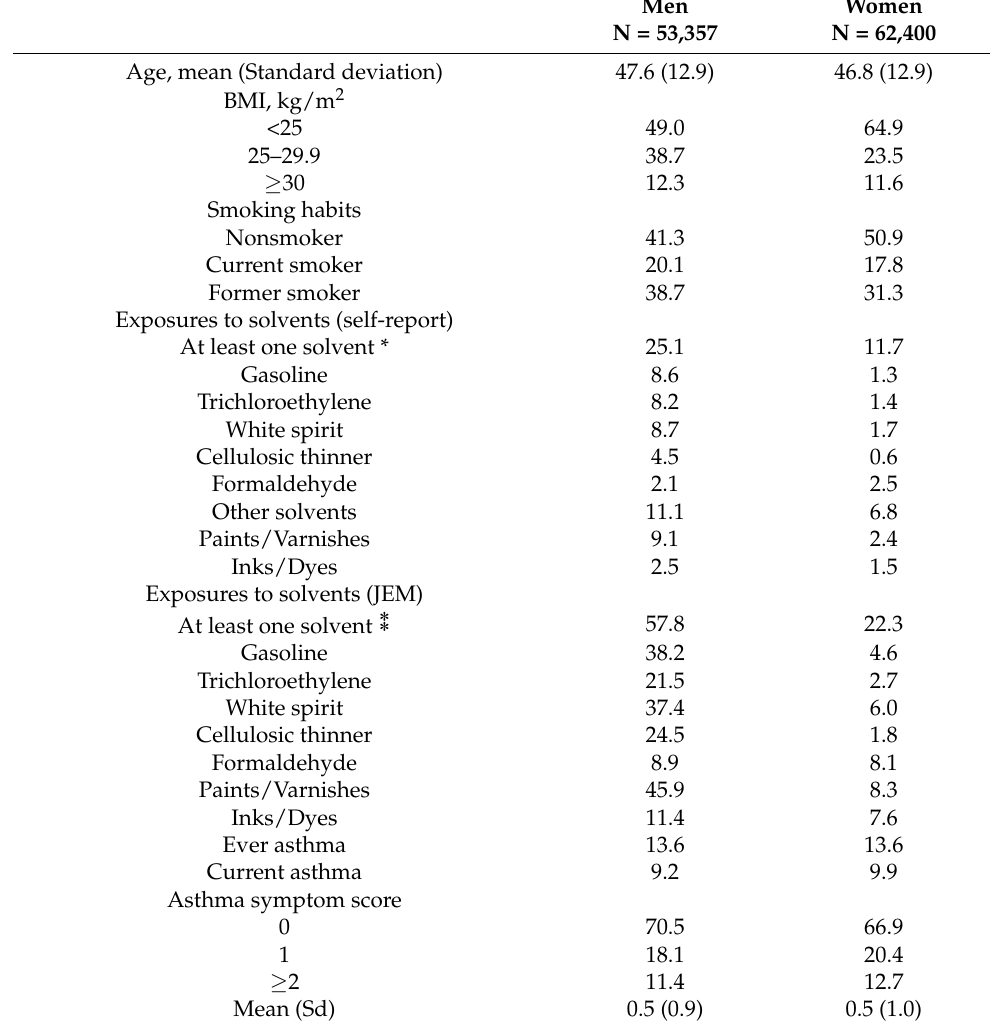
Table 1. Description of the study population.